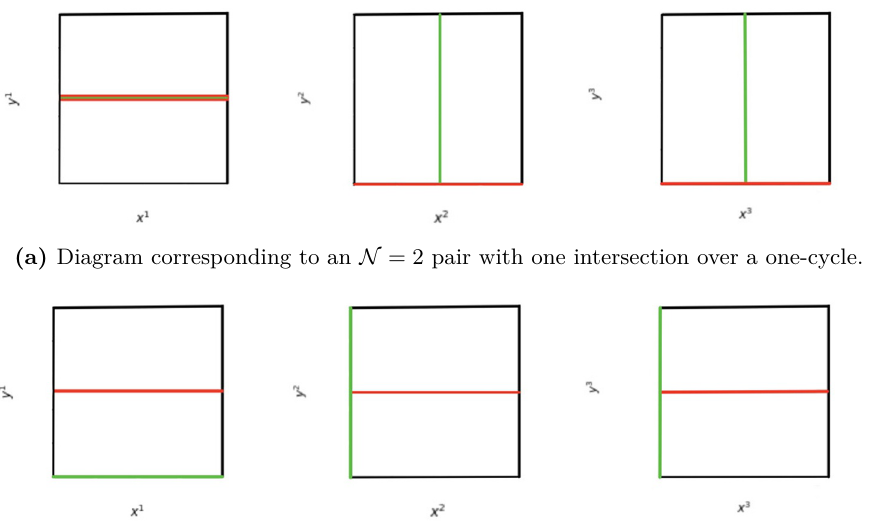
Figure 1. Configuration of 3-cycles projected over T 2 × T 2 × T 2 that contribute to (3.4) in the T 6 / Z 2 × Z 2